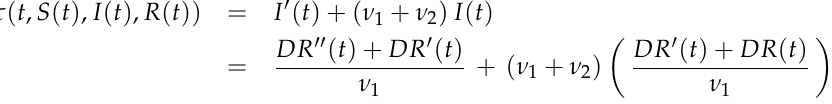
Model Equation (2) implies the transmission rate τ ( t , S ( t ) , I ( t ) , R ( t )) satisfies,